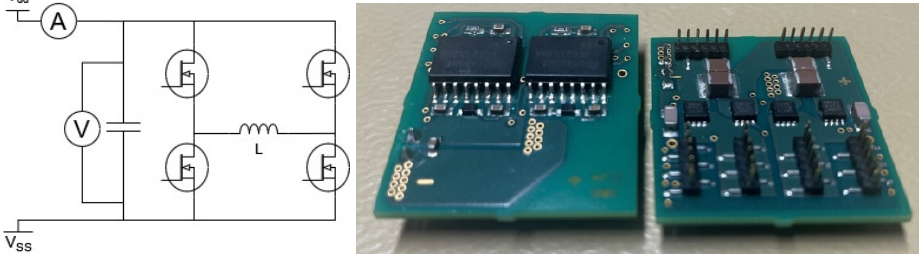
Figure 7. Bench topology for the inductor AC losses measurement under high ripple current and variable frequency. ( Left ) the schematic, ( Right ) the low voltage “high” current full-bridge inverter (30 V up to 5 A).